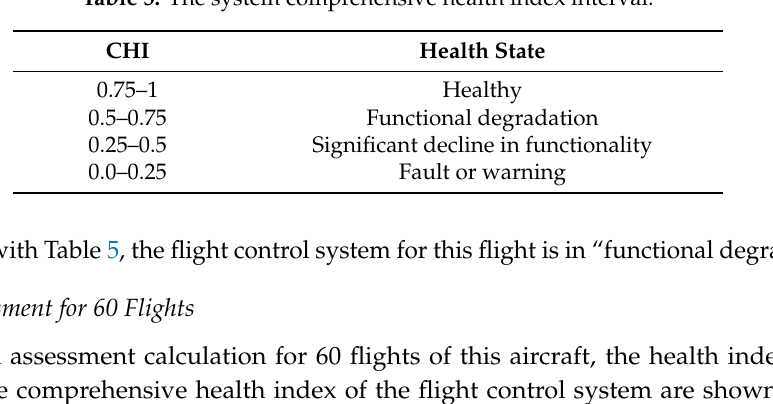
Table 5. The system comprehensive health index interval.